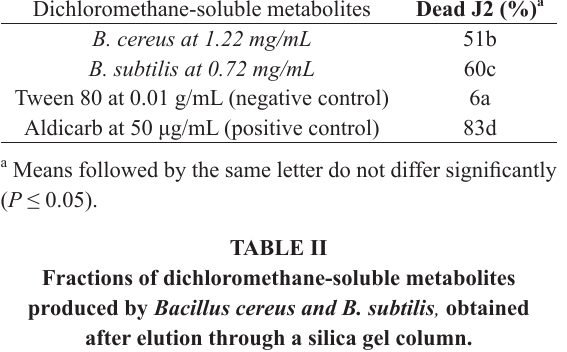
Effect of dichloromethane-soluble metabolites produced by Bacillus cereus and B. subtillis on Meloidogyne exigua second-stage juveniles (J2).